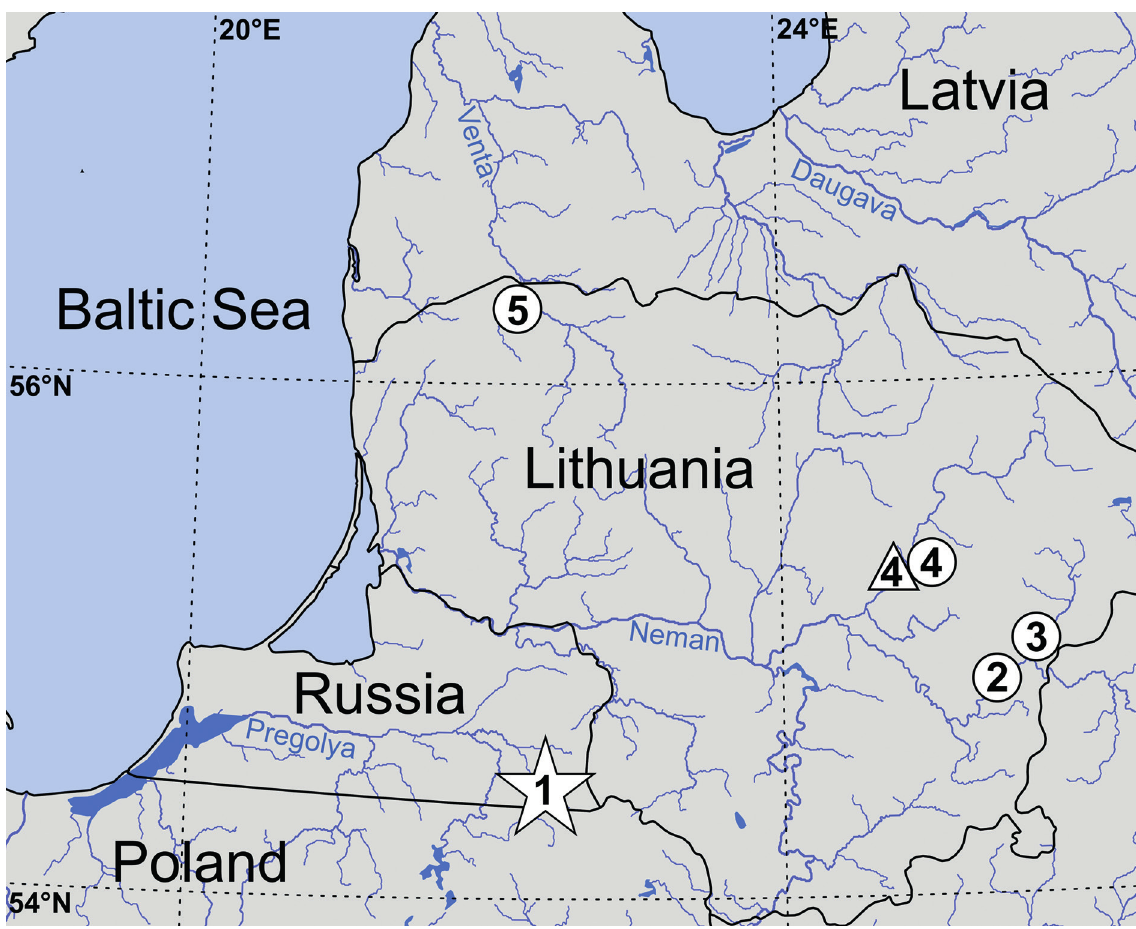
Fig. 1 . The map of sampling sites showing the distribution of Cottus cyclophtalmus sp. nov. The numbers indicate sampling sites in various rivers: 1 . Krasnaya River. 2 . Neris River. 3 . Žeimena River. 4 . Siesartis River. 5 . Šerkšnė River. The star marks the type locality of the new species; the circles mark sampling sites of non-type specimens; the triangle marks the locality where specimen of Cottus microstomus sp. nov. was